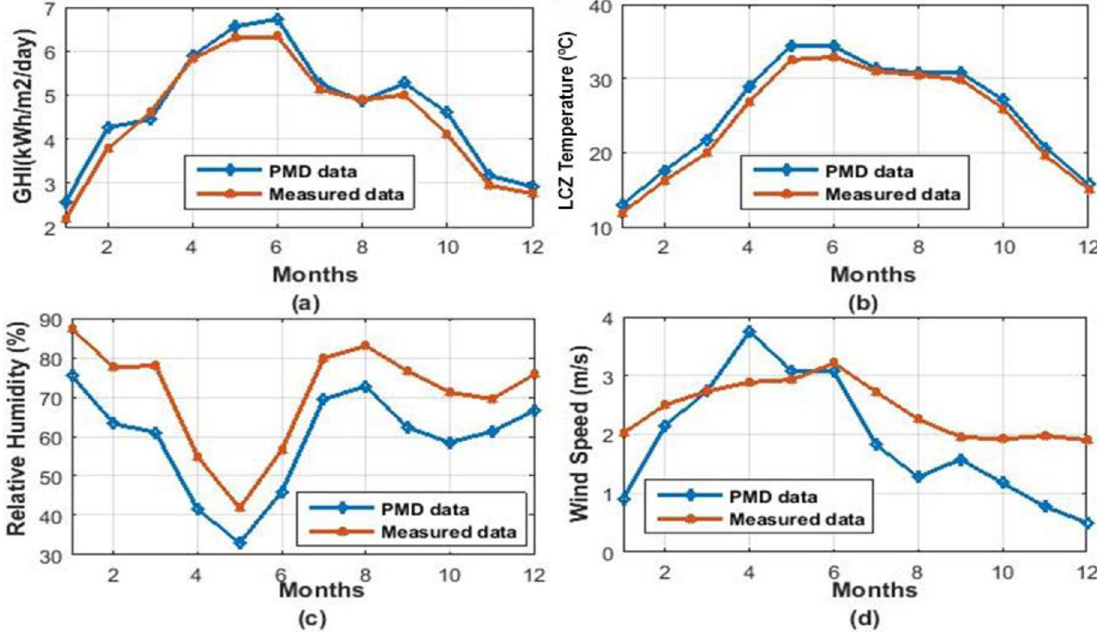
Fig 3. Weather data of Lahore. (a) Global Horizontal Irradiations (kWh/m 2 /day) (b) Dry bulb Temperature (Celsius) (c) Relative Humidity (%) ( d) Wind Speed